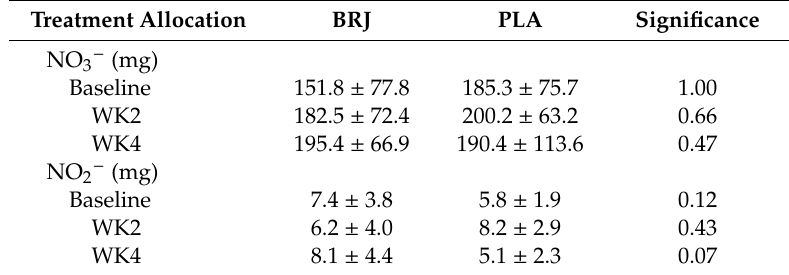
Table 3. Quantification of the amount of NO 3 − and NO 2 − , measured with a three-day self-report food diary. Treatment Allocation BRJ